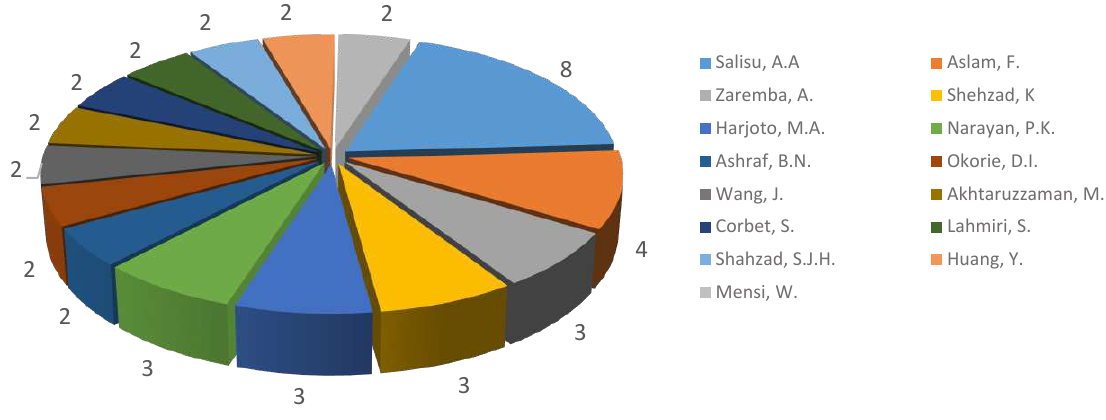
Figure 2. Pie diagram of the top 15 most productive authors on the topic of “The stock market throughout the COVID-19 pandemic” published in Scopus indexed journals from 2020 to